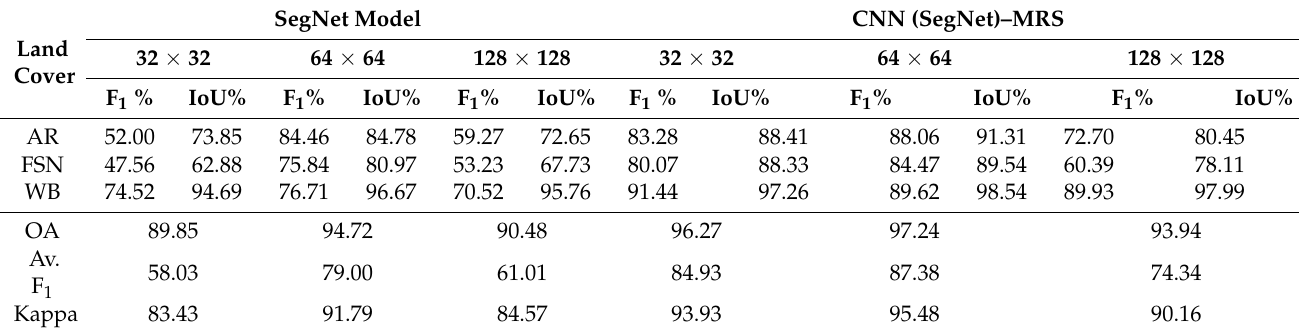
Table 11. Kocaeli test site with 5 bands: performance metrics with SegNet.